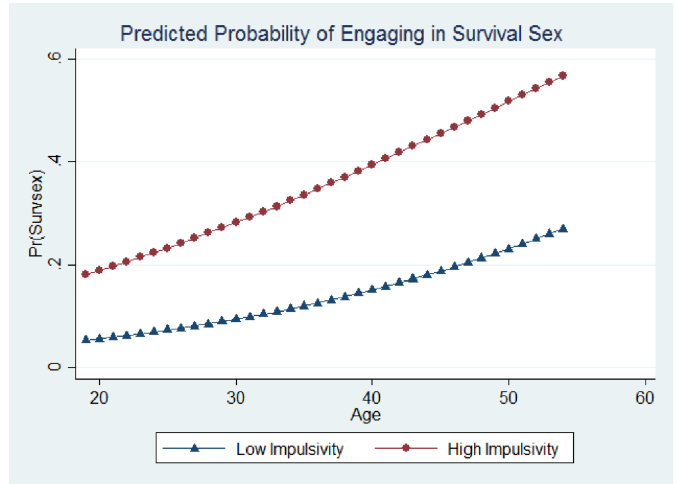
Figure 1. Predicted probability of engaging in survival